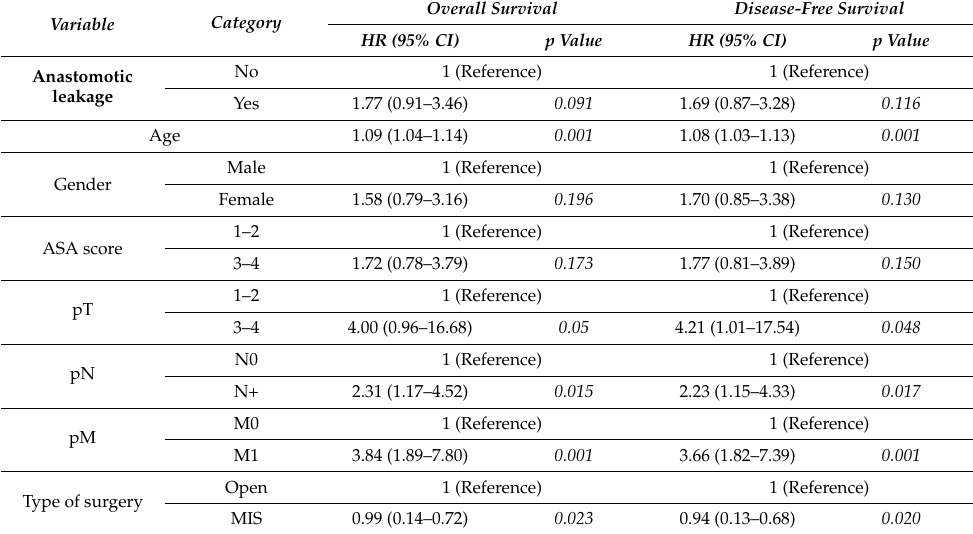
Table 3. Univariate Cox regression analysis for overall and disease-free survival in the propensity- score-matched cohort.